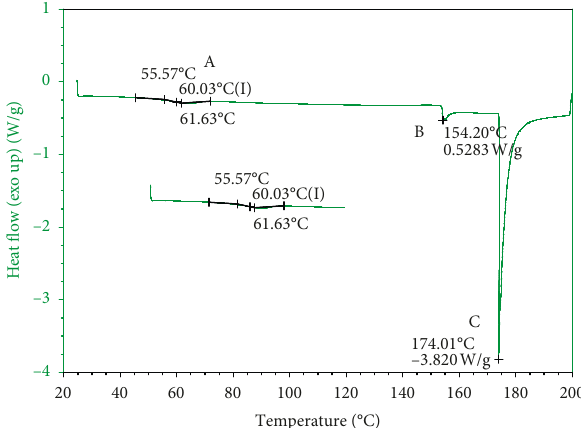
Figure 6: DSC thermograms for samples of Zn 2+ chlorophyllin microencapsulated using MD as a wall material, where a T g value of 60.03 ° C was identified. Zones of crystallisation (A), fusion (B), and degradation (C) were also